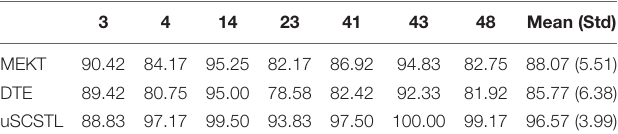
TABLE 2 | Average classification accuracies of unsupervised algorithms for good subjects on dataset MI1 ( R u =